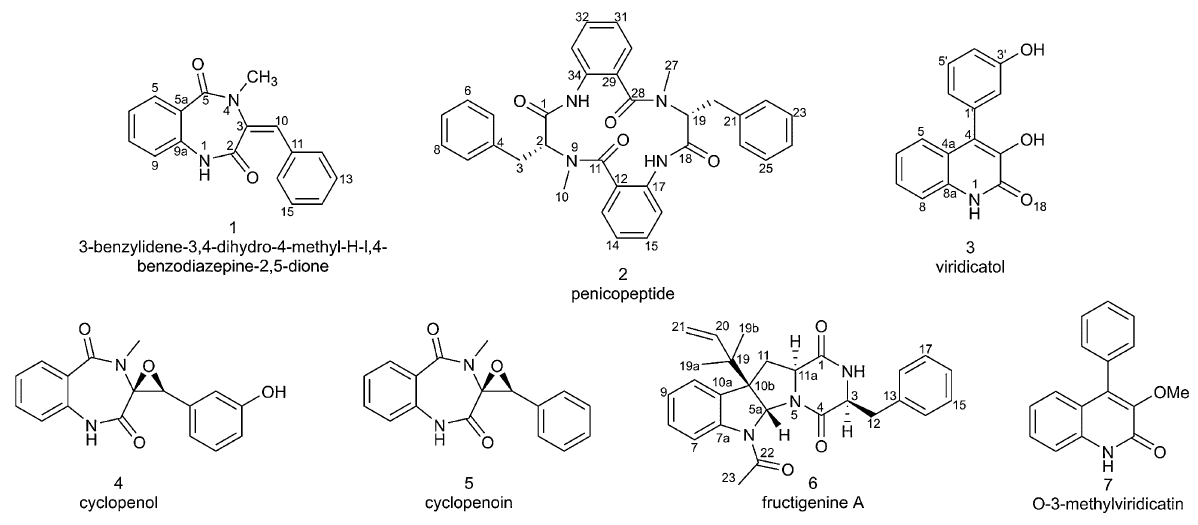
Fig. 1 Structures of compounds isolated from Penicillium sp.